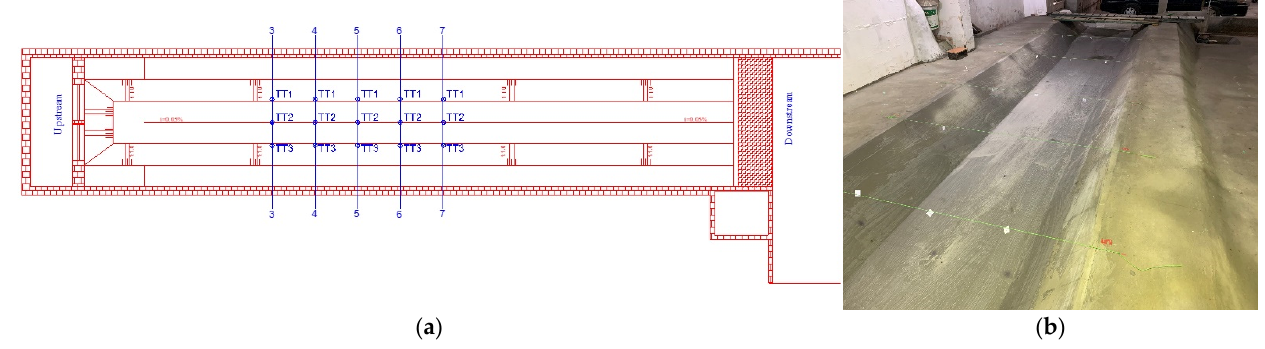
Figure 3. The water level measurement locations: ( a ) design; ( b ) experiment setup.